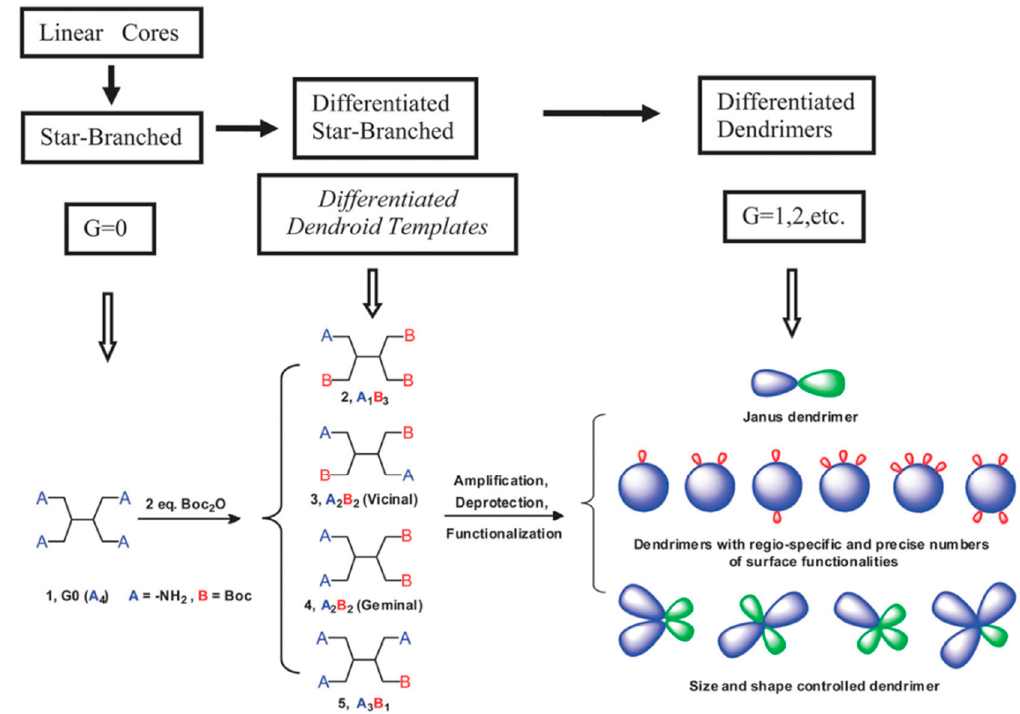
Figure 31. Schematic illustration of the differentiated dendroid template (DDT) strategy for producing higher generation regio-differentiated dendrimers. Reproduced by permission of [96]. Copyright 2013 The Royal Society of Chemistry (RSC) on behalf of the Centre National de la Recherche Scientifique (CNRS) and the RSC.